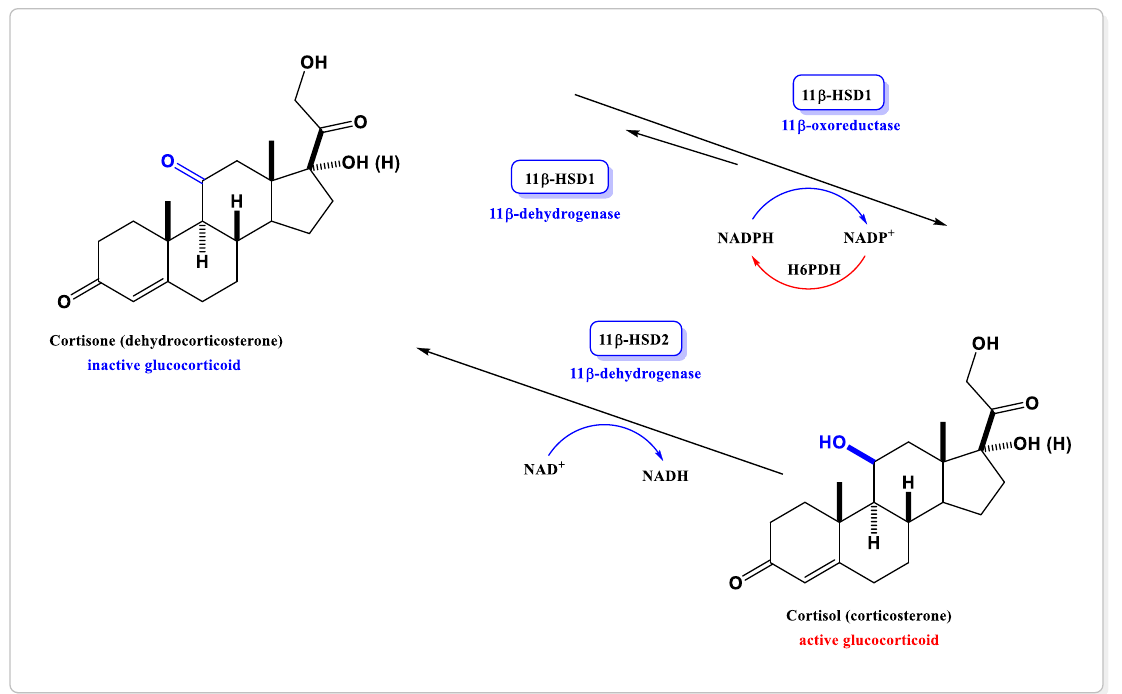
Figure 3. The physiological role of the two isoforms of 11 β -HSD. Both isoforms are microsomal enzymes localized to the endoplasmic reticulum cell membrane, but they are encoded by separate genes and differ in function, distribution in the body, and cofactor and substrate affinity—Table 1. 11 β -HSD1 is a product of the HSD11B1 gene on chromosome 1 both in humans and in rodents, while 11 β -HSD2 is encoded by a gene located on chromosome 16 in human and 8 in rodents [38,39]. Isoform 1, also called hepatic, occurs in tissues rich in the glucocorticoid receptor, mainly in the liver, brain, pancreatic islets, and adipose tissue, as well as lungs, gonads and bones [40–43]. In vitro, 11 β -HSD1 is the enzyme that has a bidirectional activity, shows the activity of NADP + -dependent 11 β -dehydrogenase in the oxidation reaction and NADPH-dependent 11-oxoreductase in the reduction reaction [44]. 11 β -HSD1 acts in vivo mainly as a reductase, thereby activating GCs from circulating 11-oxo precursors to the respective 11 β OH receptor ligands [34,42]. In most tissues, it is co-expressed in the endoplasmic reticulum with hexose-6-phosphate dehydrogenase (H6PDH), which generates NADPH requisite for reductase activity [34,37]. Isoform 2, called kidney, acts only unidirectionally, as NAD + - dependent dehydrogenase. Compared to 11 β -HSD1, it is expressed in tissues rich in the mineralocorticoid receptor (MR), mainly in the kidneys, large intestine, salivary glands, and placenta, and is characterized by a much higher affinity for cortisol (100 times greater than 11 β -HSD1)